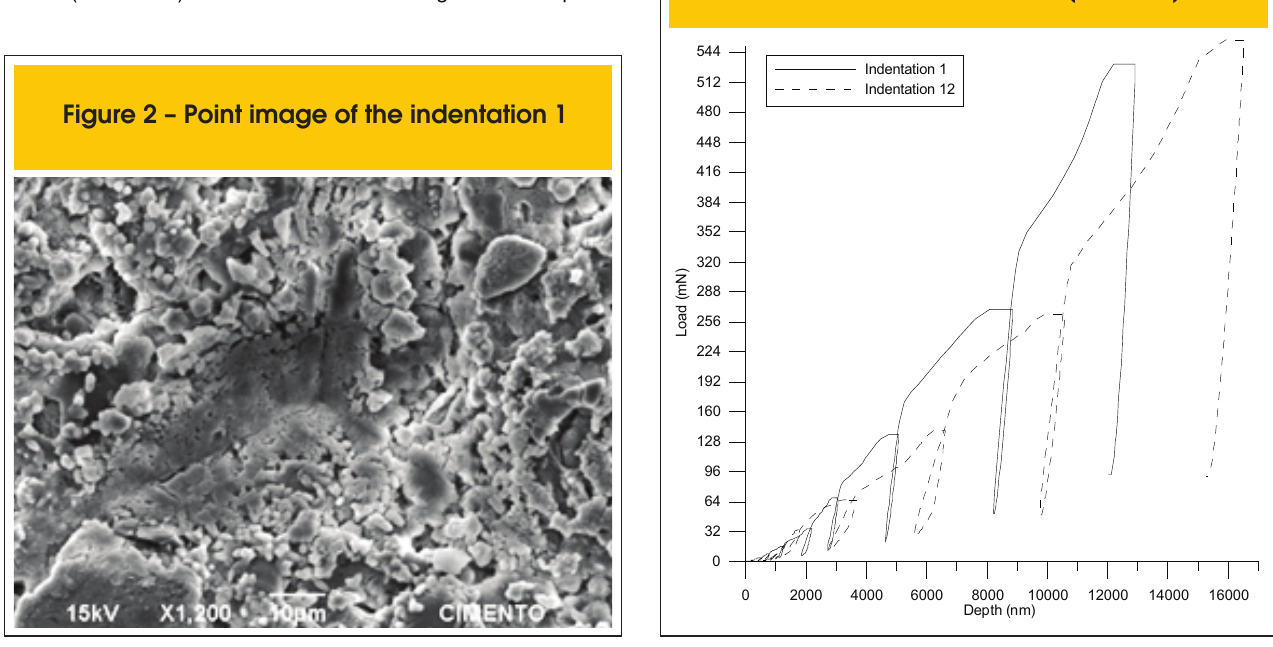
Figure 4 – Load-displacement curves for the indentations 1 and 12 (matrix